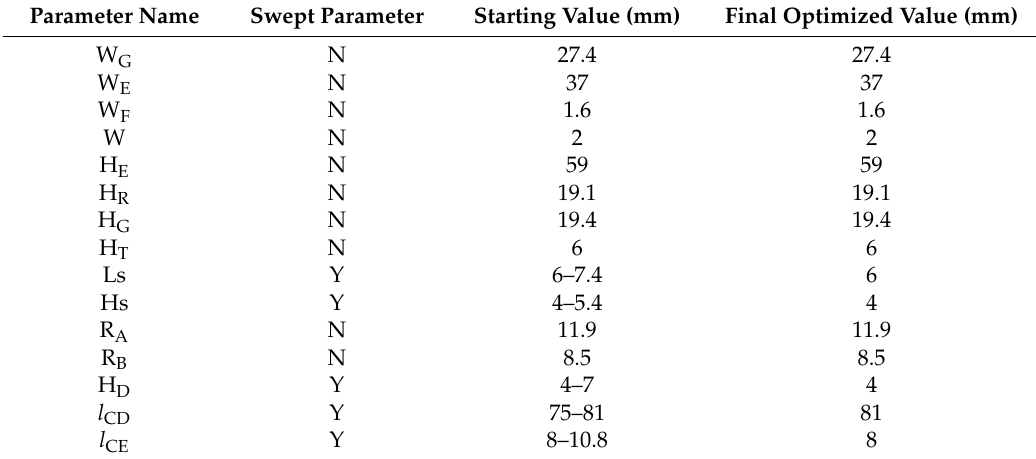
Table 5. Tabulated values of the antenna physical parameters (free-space).